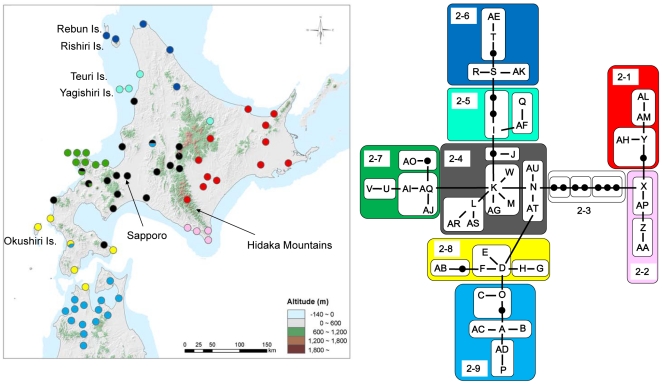
The minimum spanning network of 16S mtDNA in the Japanese crayfish (Cambaroides japonicus) and the distribution of level-2 nested clade (represented in the same colors).Note that the network configuration and distribution of haplotypes and nested clades are matched very well (e.g. interior haplo-groups distribute central areas, whereas tip haplo-groups distribute peripheral areas). All islands share haplotypes with the nearest main islands, including southern Hokkaido and northern Honshu. Black circles in the network represent missing haplotypes.